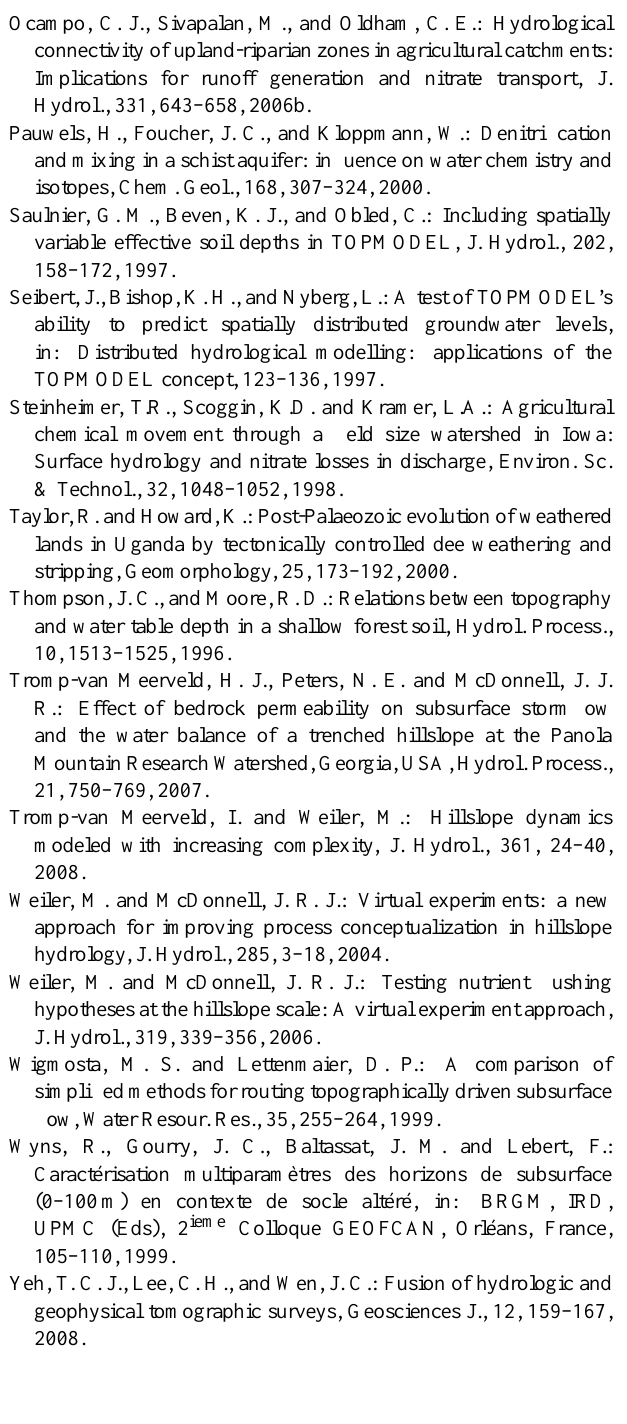
table predictions using a generalized TOPMODEL